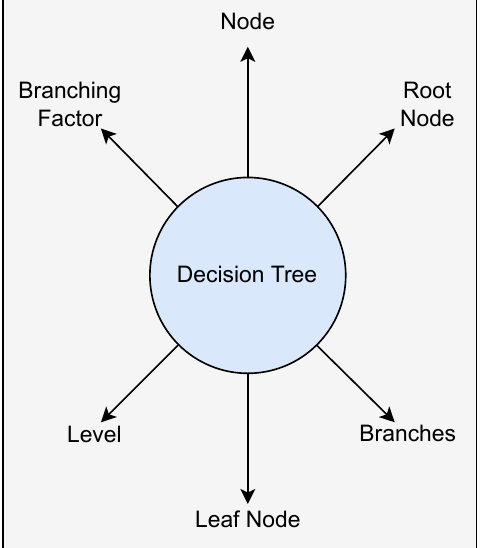
Figure 3. Various parameters of Decision